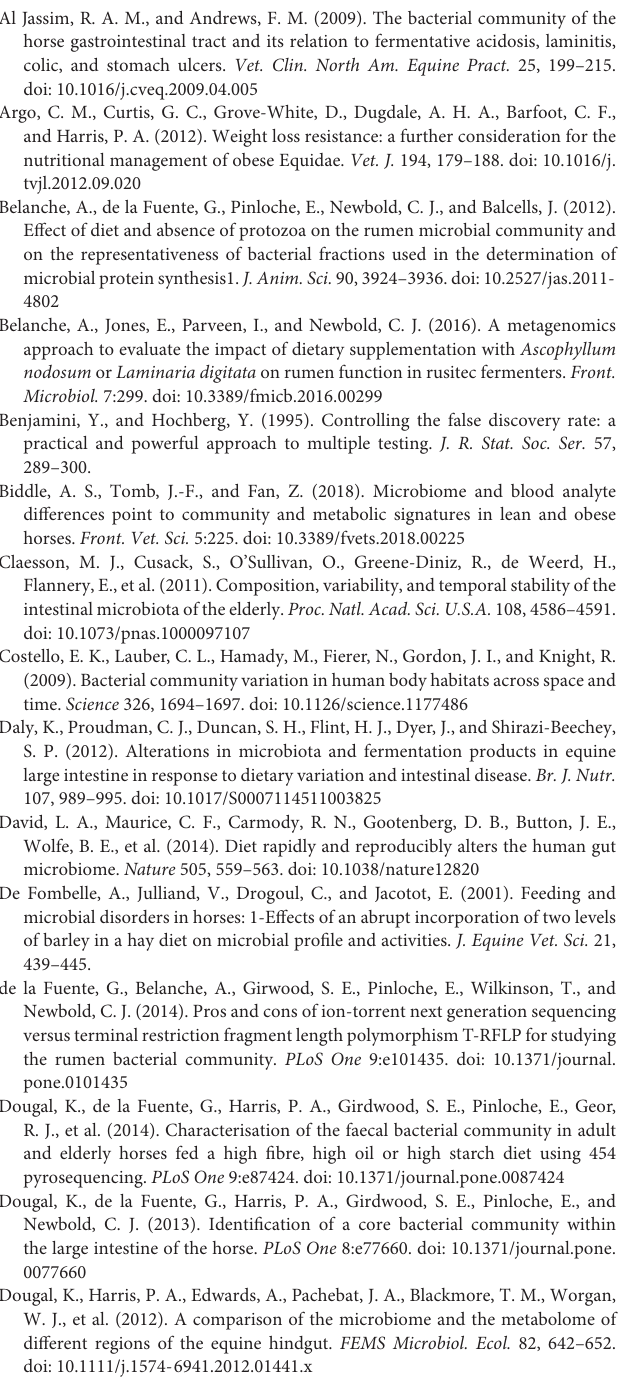
TABLE S5 | Relative abundance of bacterial OTUs significantly different in abundance between Control and Aged groups following Deseq analysis. TABLE S6 | Relative abundance of bacterial OTUs significantly different in abundance between Obese and Aged groups following Deseq analysis.